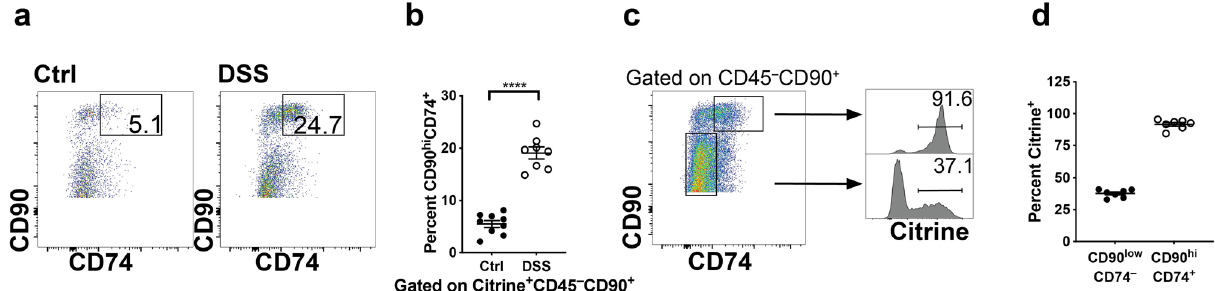
Figure 6. Citrine + fibroblasts induced by DSS are CD90 hi CD74 + inflammatory fibroblasts. ( A ) Flow cytometric analysis and ( B ) quantification of CD90 hi CD74 + cells gated on citrine + CD45 − CD90 + fibroblasts in the colon lamina propria at baseline and during DSS-induced colitis. ( C ) Flow cytometric analysis and ( D ) quantification of citrine + cells gated on CD45 − CD90 + fibroblasts to show which fibroblast population is mainly expressing IL-33-citrine during DSS. N = 8–9 mice/group ****p <